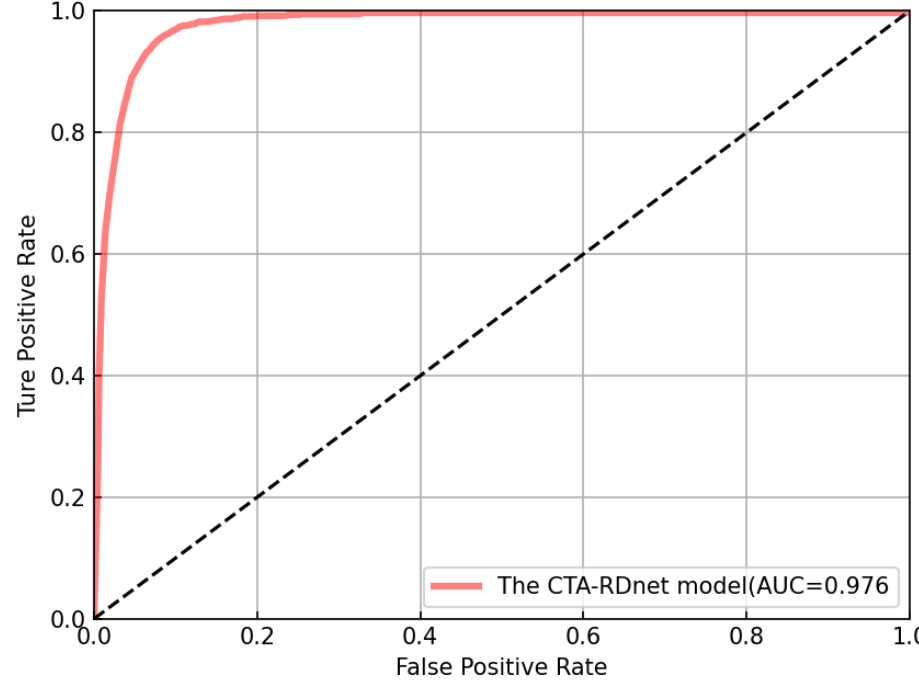
Figure 10. The confusion matrix of the CTA-RDnet.